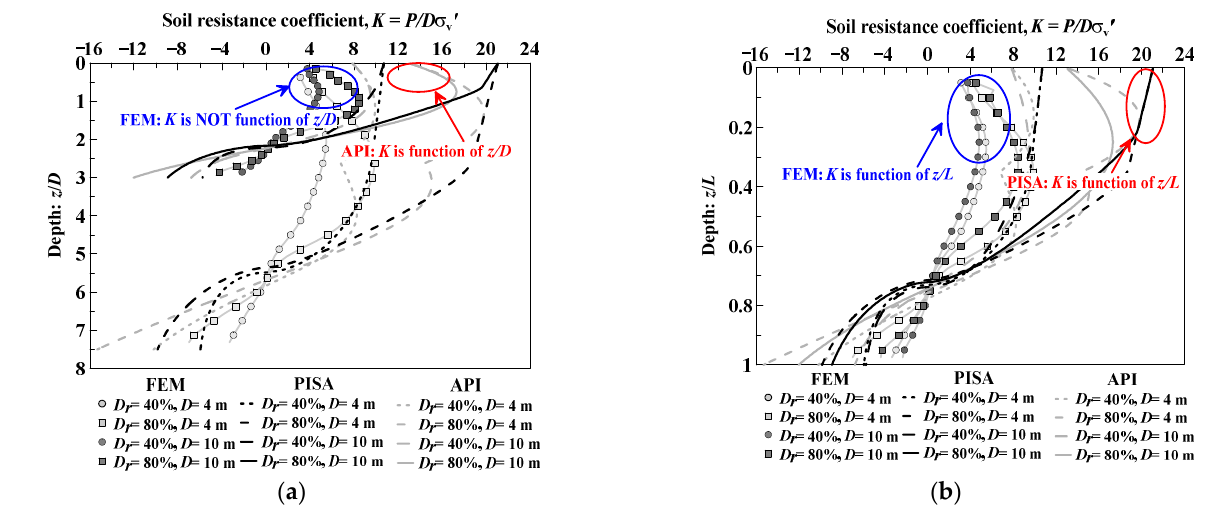
Figure 19. Soil resistance coefficient profiles at 4 degrees in 40% and 80% relative density sands against: ( a ) z/D , ( b ) z/L .